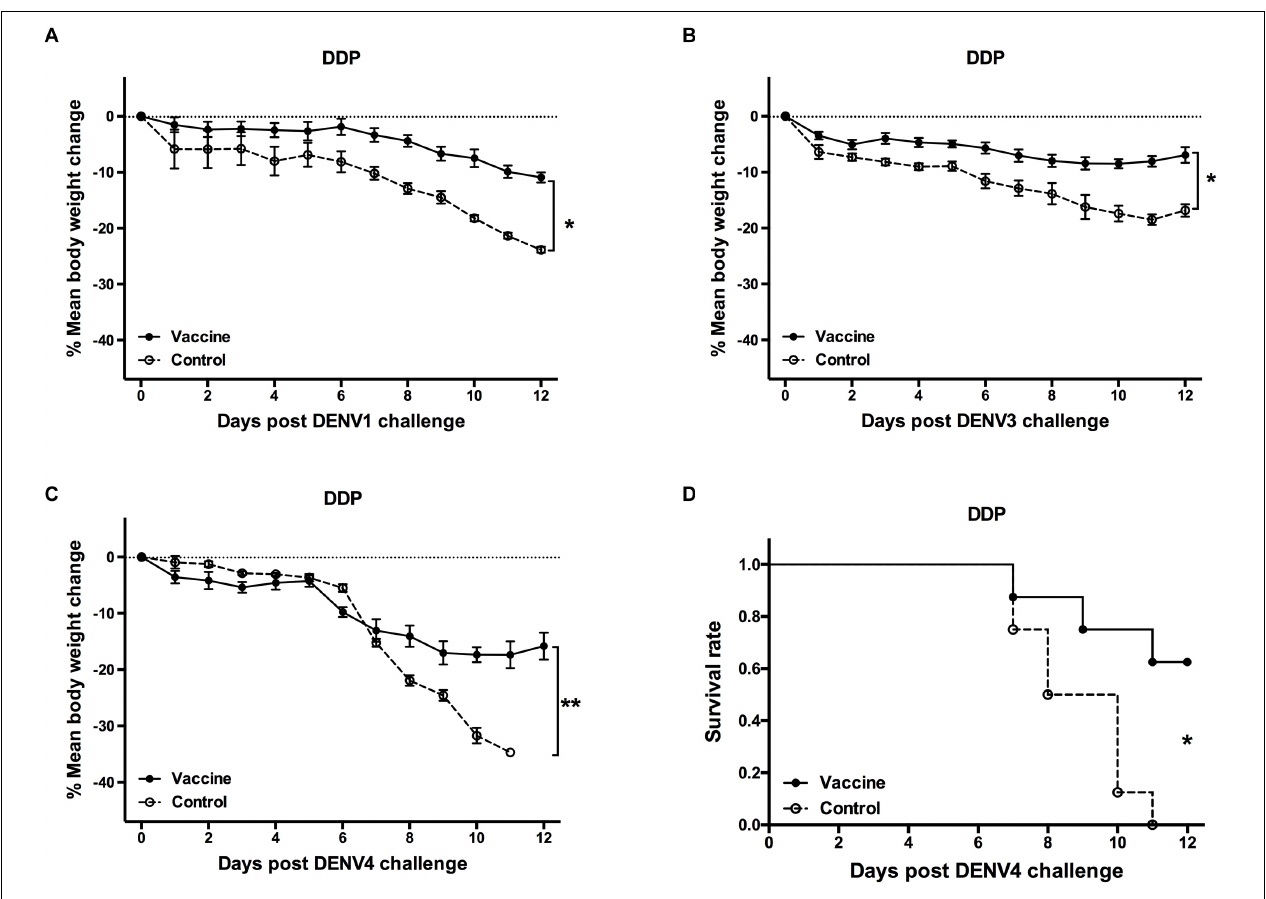
FIGURE 6 | Protective efficacy against DENV1, DENV3, and DENV4 induced by the DDP immunization regimen. Mice immunized with the DDP regimen were challenged i.c. with DENV1, DENV3, and DENV4 and monitored daily for 12 days ( n = 8). Percentage changes of body weight from day 0 after challenge with (A) DENV1, (B) DENV3, and (C) DENV4. The percentage was determined as 100 × (weight post-challenge)/(weight pre-challenge). Data were expressed as mean ± SD. (D) The survival rate post challenge with DENV4 was shown as the percentage of survivors. ∗ P < 0.05, ∗∗ P <